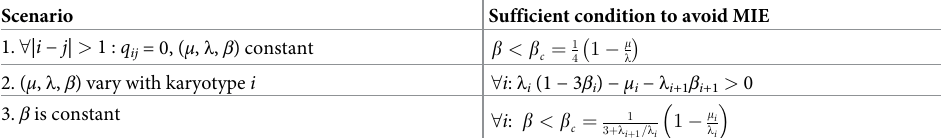
Table 2. Sufficient conditions to avoid MIE for various biological scenarios. 1) Only � 1 chromosome can missegre- gate per division; all rates are independent of karyotype (i.e. homogeneous). 2) Heterogeneous birth-, death-, and/or missegregation rates. 3) Homogeneous missegregation